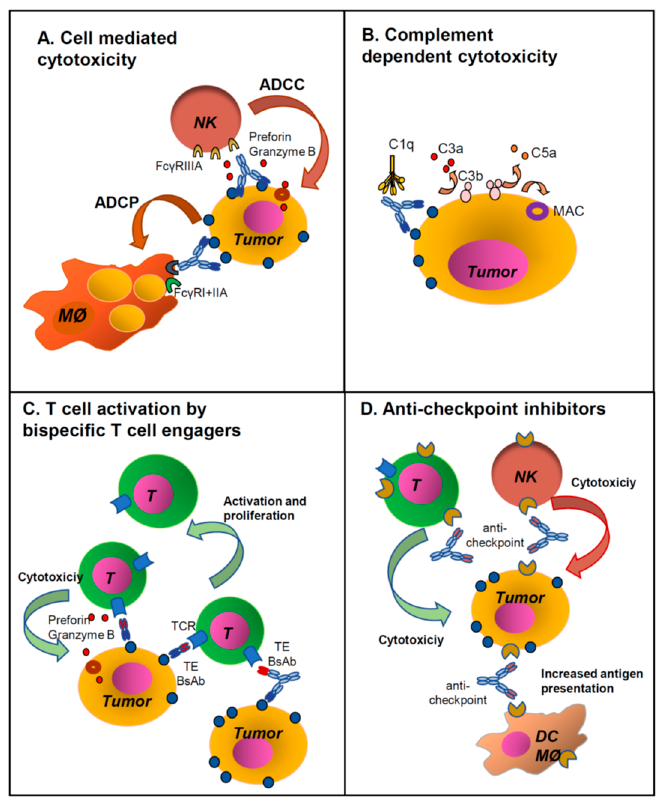
Figure 1. Major mechanisms of action of monoclonal and bispecific antibodies. Unconjugated IgG1 monoclonal antibodies (MAbs) work generally through activation of immune effector mechanisms through their Fc regions: ( A ) Antibody-dependent cellular cytotoxicity (ADCC) by NK cells and antibody-depndent phagocytosis (ADCP) by macrophages, ( B ) activation of the complement cascade. ( C ) T cell engaging bispecific antibodies (BsAbs) with or without Fc, act by binding a tumor antigen (TA) and CD3 on T cells (CD3 x TA). This induces activation of cytotoxic T cells which proliferate and kill the tumor cells. ( D ) Antibodies against immune checkpoint inhibitors (ICI) mostly block interaction of the ICI with their ligands, thus activating immune cells. This takes place via the Fab interaction with the ligand, blocking ICI function. In some cases, the MAbs may have a functional IgG1 Fc and eliminate ICI expressing cells through ADCC / ADCP or complement-dependent cytotoxicity (CDC). See also Table 1 for abbreviations.